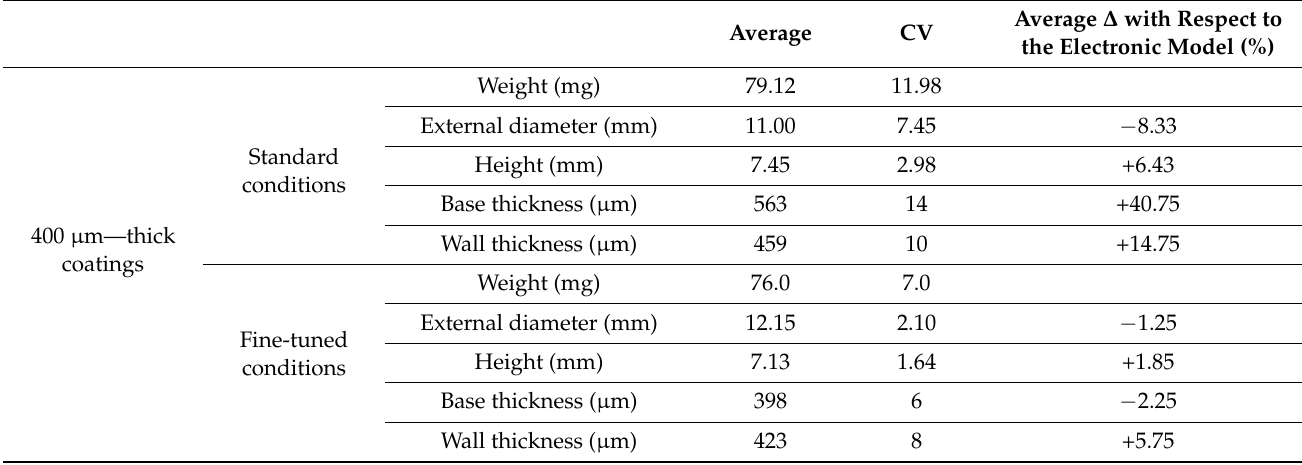
Table 3. Weight and dimension characteristics of EDR-based